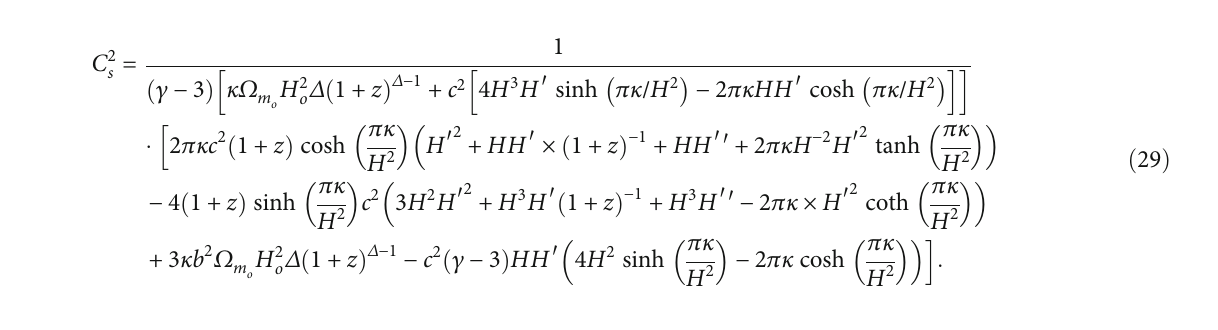
Figure 1: Behavior of deceleration parameter q against redshift parameter z considering di ff erent values of κ when Ω = 0 : 5 , H = 67 : 9 , ω = − 0 : 3 , c 2 = 0 : 313 , and γ = 0 : 127 . o